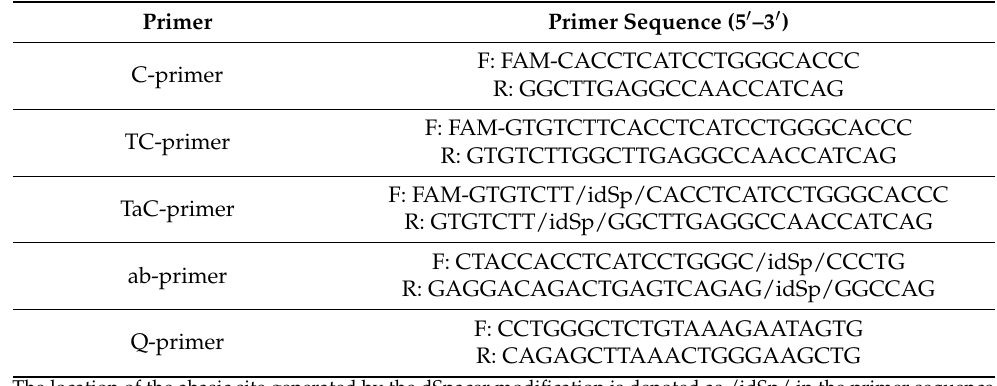
Table 1. Overview of primer sets for detection of AMEL locus in the primer extension assay and the quantification